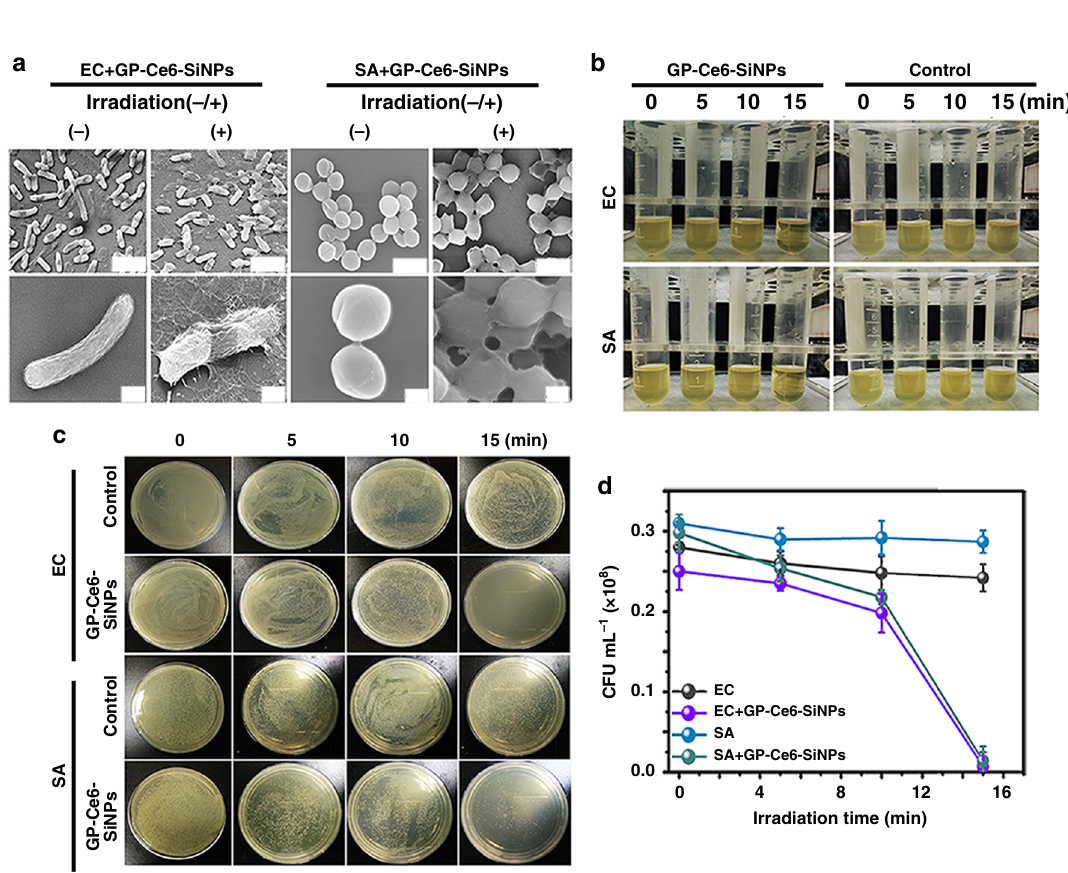
Fig. 5 In vitro antibacterial activity of GP-Ce6-SiNPs. a SEM images of GP-Ce6-SiNPs-treated EC and SA before and after constant 660-nm irradiation (12 mW cm − 2 ) for 15 min (scale bar in the fi rst row: 1 μ m, scale bar in the second row: 200 nm). b The turbidity of EC and SA suspensions treated without GP- Ce6-SiNPs (control groups) or with GP-Ce6-SiNPs under constant irradiation (660 nm, 12 mW cm − 2 ) for 0, 5, 10, and 15 min. The irradiation treatment on each sample is performed for one time. c Photographs of the agar plates of EC and SA treated without (control groups) or with GP-Ce6-SiNPs under constant irradiation (660 nm, 12 mW cm − 2 ) for 0, 5, 10, and 15 min. d , The corresponding bacterial counts (CFU mL − 1 ) in panel ( c ). Error bars represent the standard deviation obtained from three independent measurements. The concentration of GP-Ce6-SiNPs is 10 mg mL − 1 (3.6 mg mL − 1 of GP and 100 μ g mL − 1 of Ce6). Source data are provided as a Source Data fi